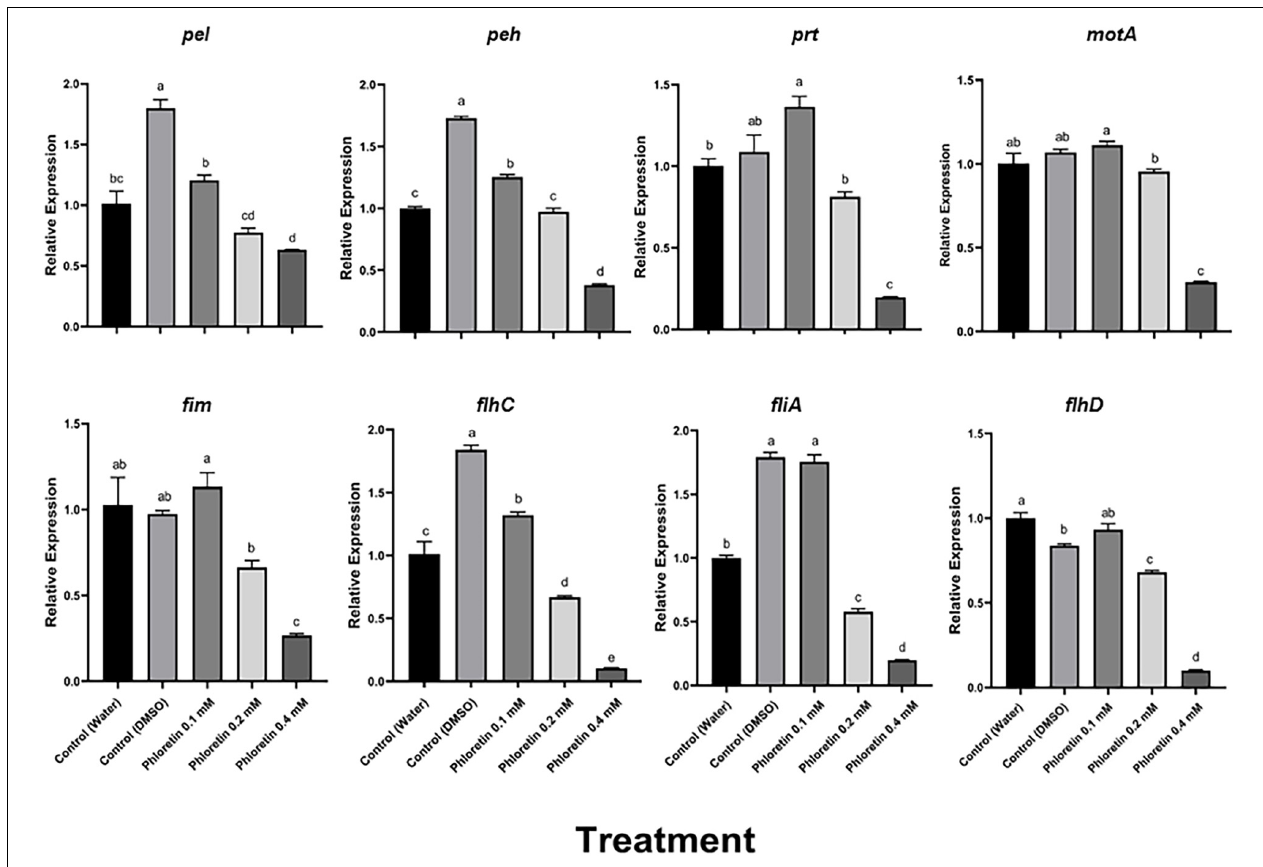
FIGURE 7 | Effects of phloretin on transcript levels of genes associated with PCWDE and motility in Pectobacterium brasiliense Pb1692. The expression levels of PCWDE-related genes ( Pel, Peh and Prt ) and motility-related genes ( motA, fim, fliA, flhC and flhD ) were determined by qPCR of cDNA samples prepared from RNA extracts from bacterial cultures grown in LB (28 ◦ C, 8 h, continuous shaking at 150 rpm) in the presence of phloretin (0.1, 0.2, and 0.4 mM), dH 2 O or 0.3% DMSO. Bars represent the relative gene expression in one experiment, with means + standard errors (SE) of 6 replicates per treatment. The experiments were repeated twice with similar results. Bars that are not labeled with the same letter are significantly different from each other ( P < 0.05; bar = mean + SE; n =